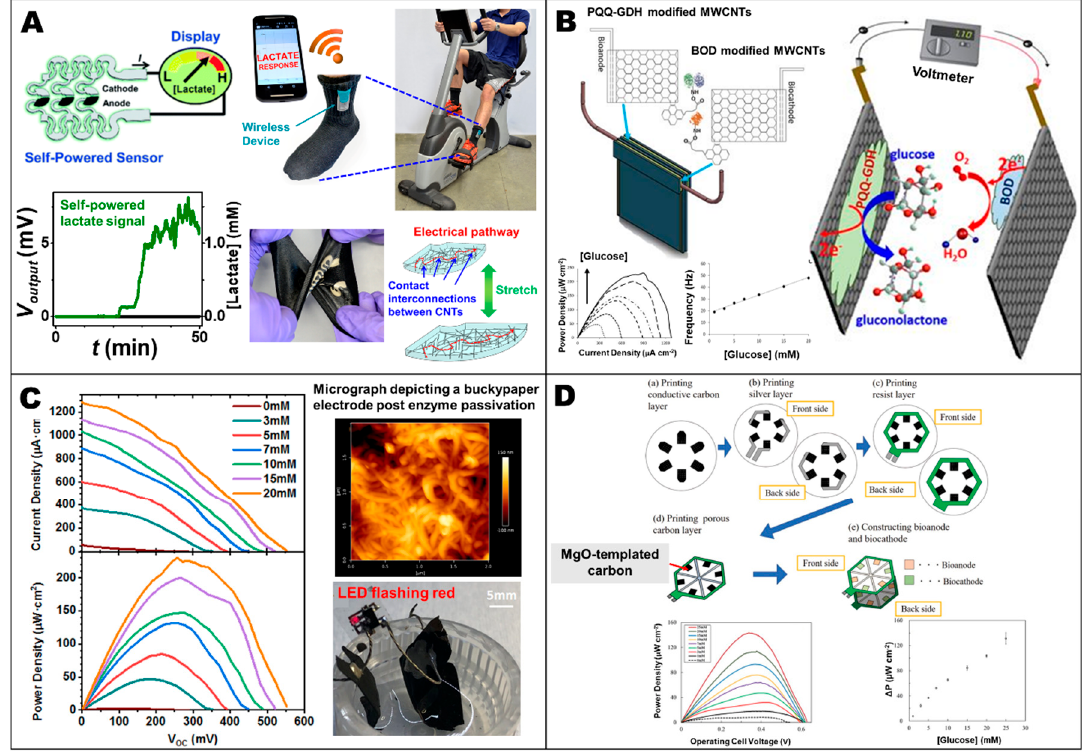
Figure 7. Examples of applications of carbon materials for self-powered sensors. ( A ) Wearable textile-based self-powered sensors, utilizing stretchable CNT-based electrodes. Adapted with permission from [15] , Copyright 2016, The Royal Society of Chemistry. ( B ) Self-powered glucose sensor, utilizing a capacitor circuit and CNT-based electrodes. Adapted under the terms and conditions of the CC-BY license from [67] , Copyright 2017, Slaughter et al., published by Nature Publishing Group. ( C ) Fully flexible autonomous glucose indicator, utilizing buckypaper-based bioelectrodes. Adapted under the terms and conditions of the CC-BY from [68] , Copyright 2019, Yuen et al., published by Nature Publishing Group. ( D ) Self-powered glucose biosensor, utilizing screen-printed MgO-templated carbon electrodes. Adapted under the terms and conditions of the CC-BY license from [69] , Copyright 2019, Shitanda et al., published by the Electrochemical Society.